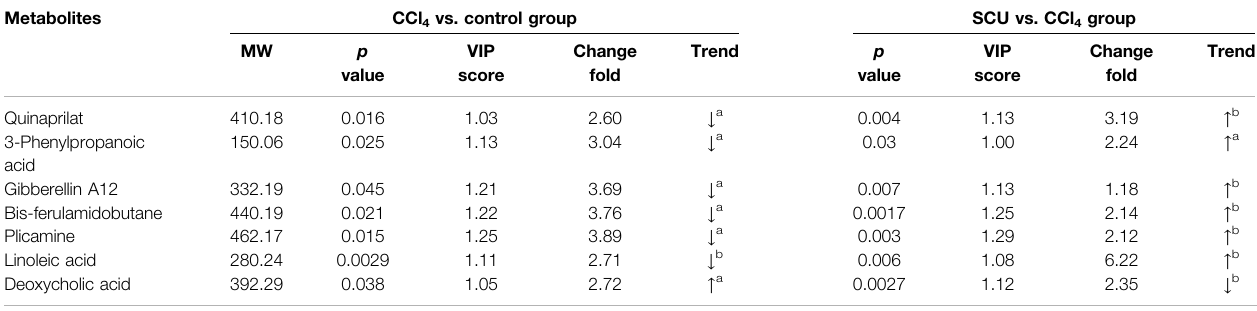
TABLE 1 | Altered metabolites in feces among the control, CCl 4 , and the SCU group.